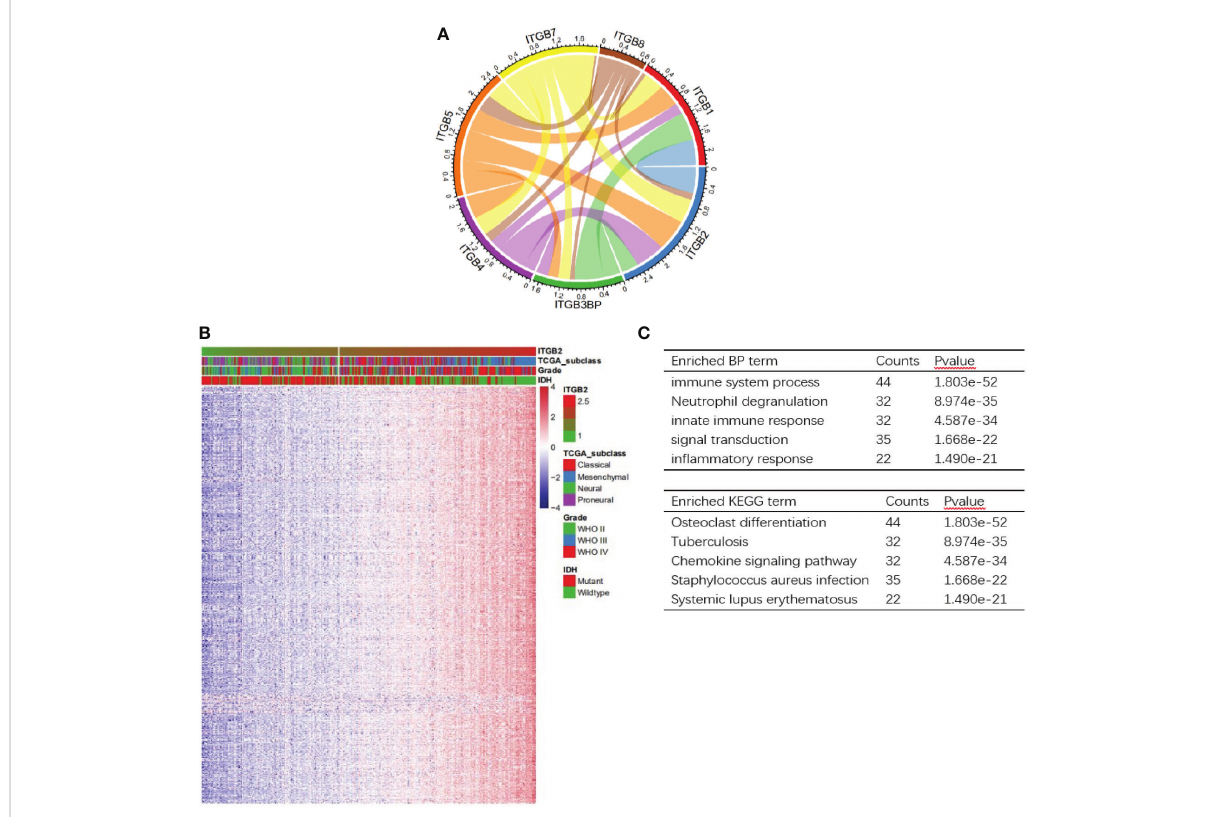
FIGURE 5 Analysis of biological processes related to ITGB2. (A) Correlation of ITGB2 with ITGB molecular in the CGGA RNA-seq set. (B) One hundred fourty genes positively related (R> 0.8) with ITGB2 expression. (C) The BP and KEGG analysis results show that ITGB2 expression is related to immune function of gliomas. Counts represents the number of genes enrichment.